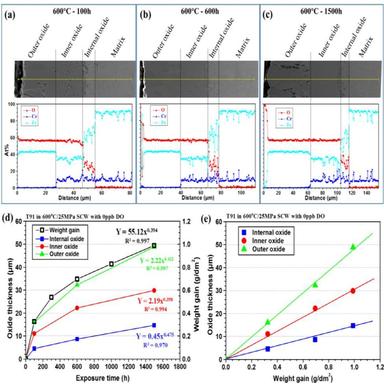
Cross-sectional SEM-EDX line scanning results of the surface oxide film on T91 exposed to SCW for (a) 100 h, (b) 600 h and (c) 1500 h at 600 °C; (d) the oxide thickness and weight gain as a function of exposure time; (e) the oxide thickness as a function of weight gain in each oxide layer.